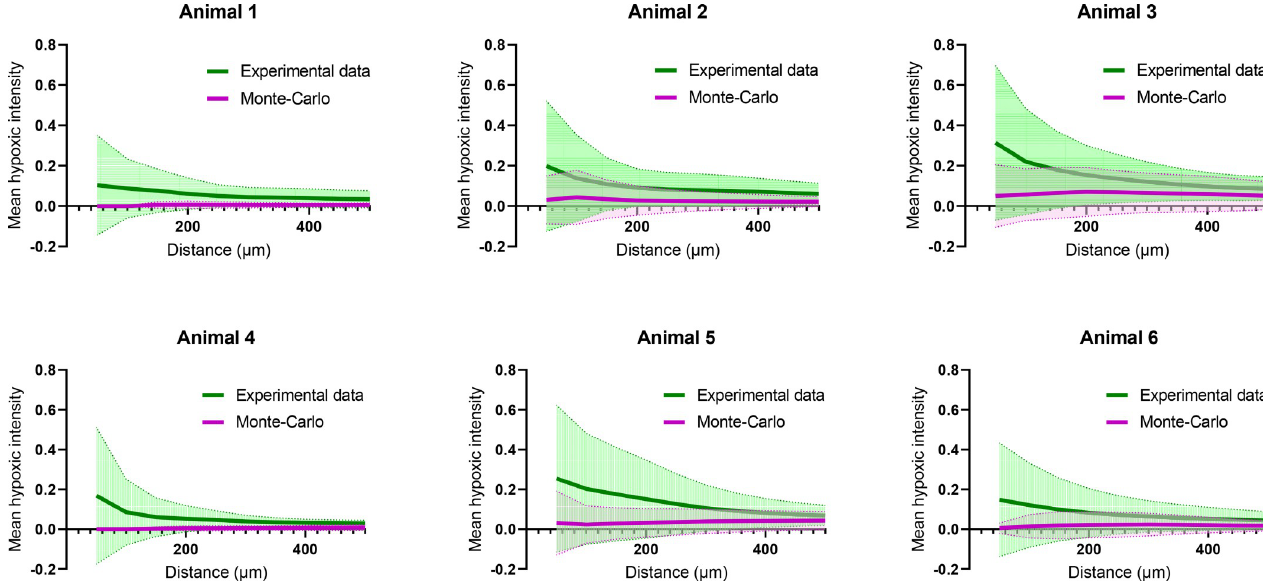
Fig 6. Per animal experimental data versus Monte-Carlo simulations. Monte-Carlo simulations: hypoxic intensity as a function of the distance from random control points. Mean ± standard deviation (filled areas) (all microspheres or control points of n = 6 animals).